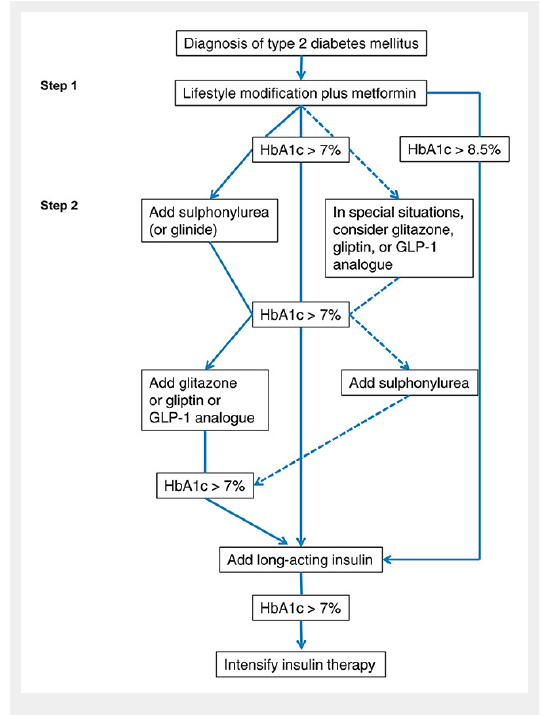
Figure 1 SSED 2009 treatment recommendations for type 2 diabetes. Adapted, with permission, from reference 6 (Swiss Med Forum. 2009;9(3):50-5. GLP-1 = glucagon-like peptide-1; HbA1c = glycated haemoglobin